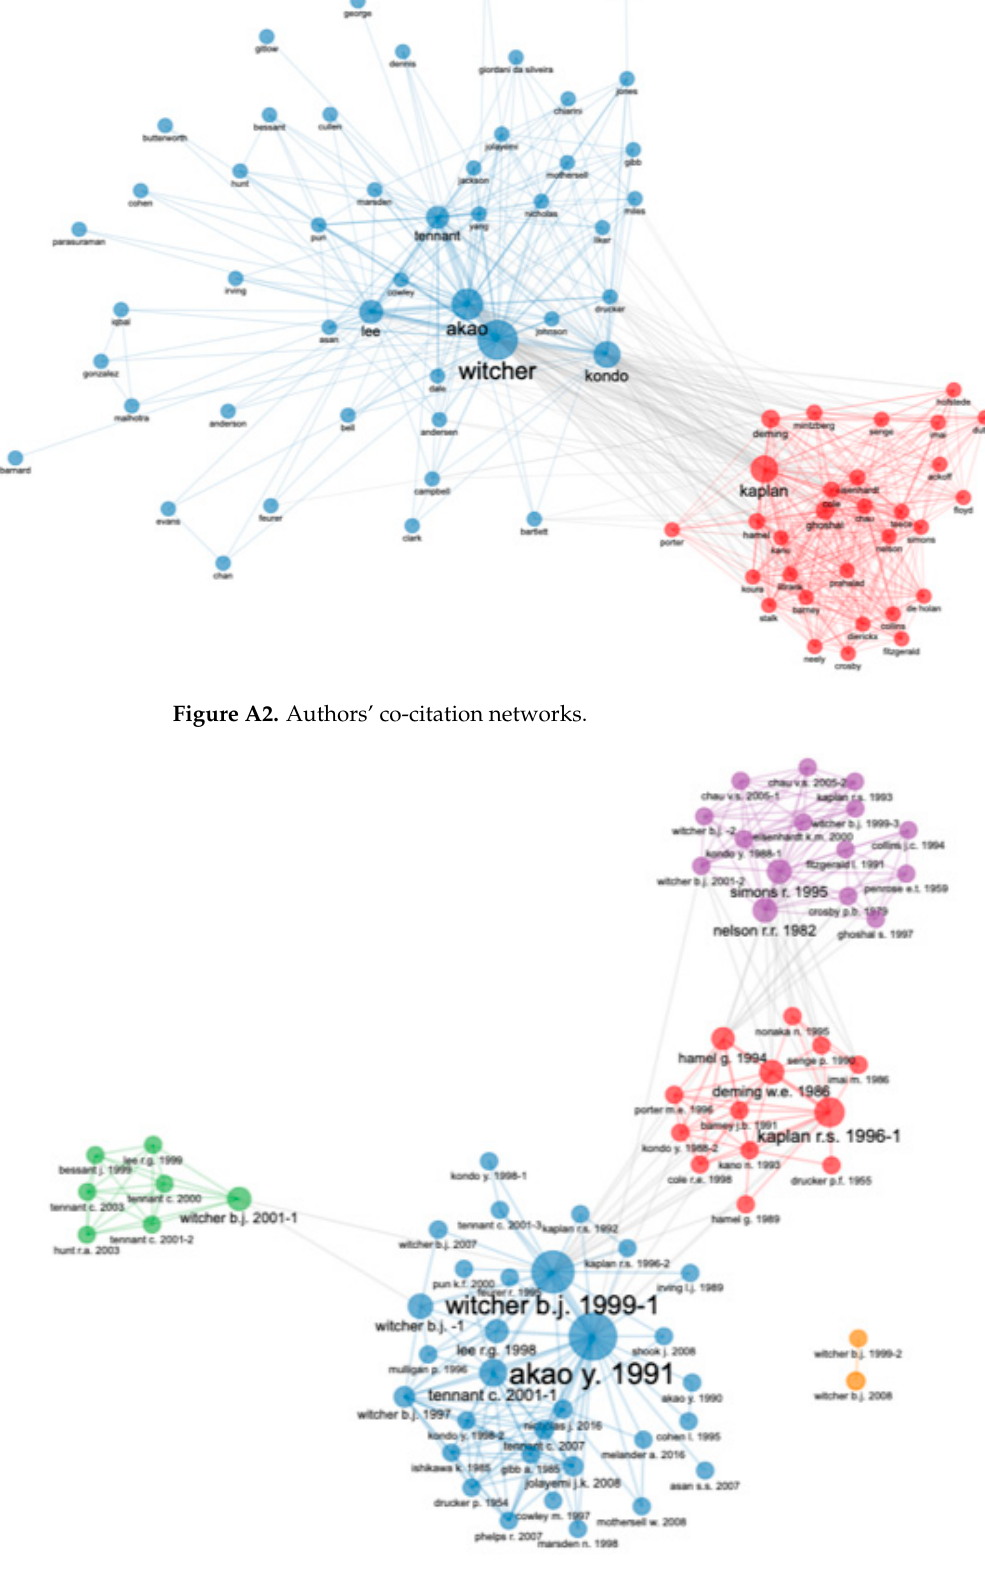
Figure A3. Papers’ co-citation networks.